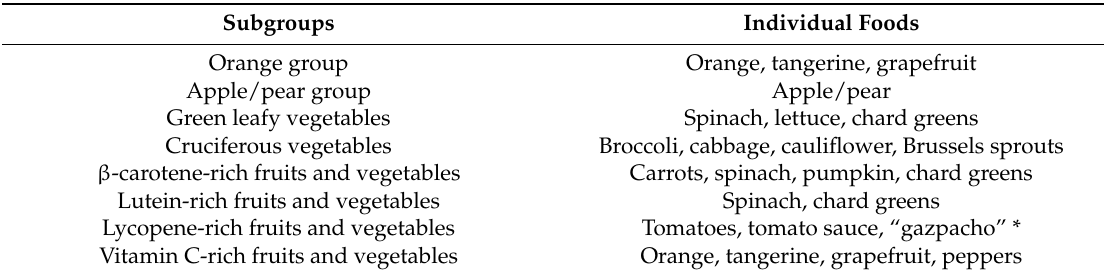
Table 1. Definitions for various fruit and vegetable